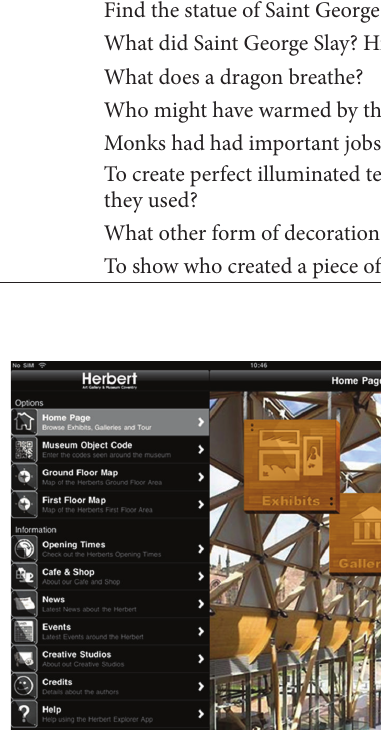
Figure 8: The gallery virtual museum.